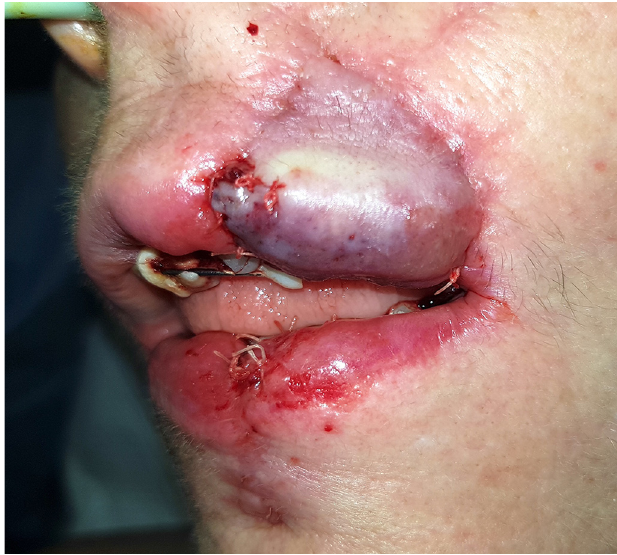
Fig. 4. Immediate postoperative aspect after weaning of the graft: venous